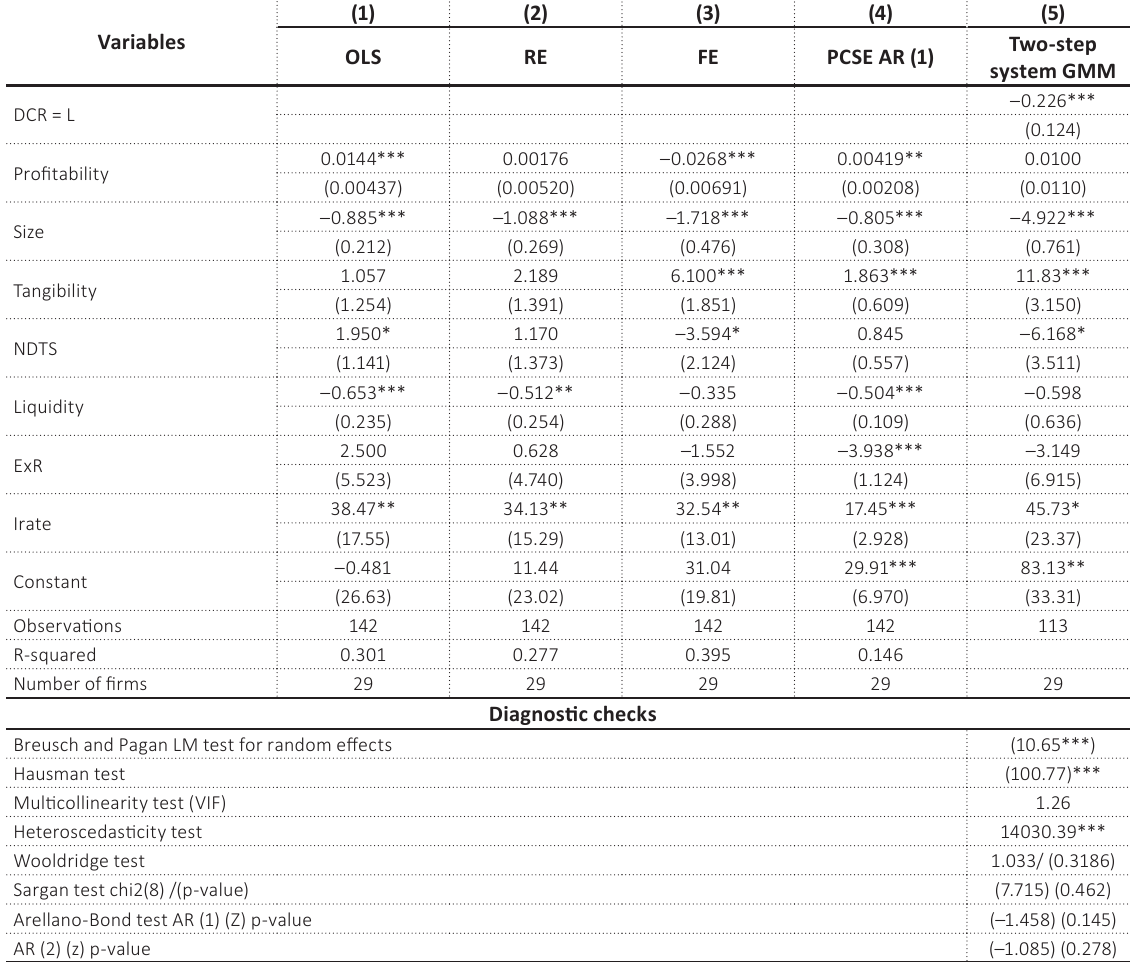
Table 4. Linear regression